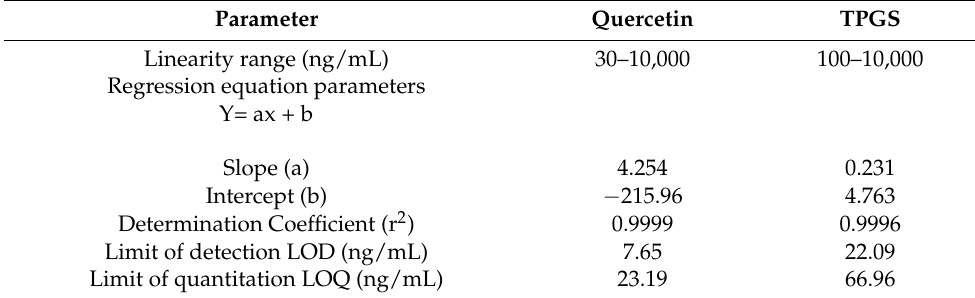
Figure 4. Calibration curves for Quercetin, A , and D- α -Tocopherol polyethylene glycol 1000 succinate (TPGS), B . Table 2. Validation parameters of the proposed HPLC-UV method in spiked rat plasma.